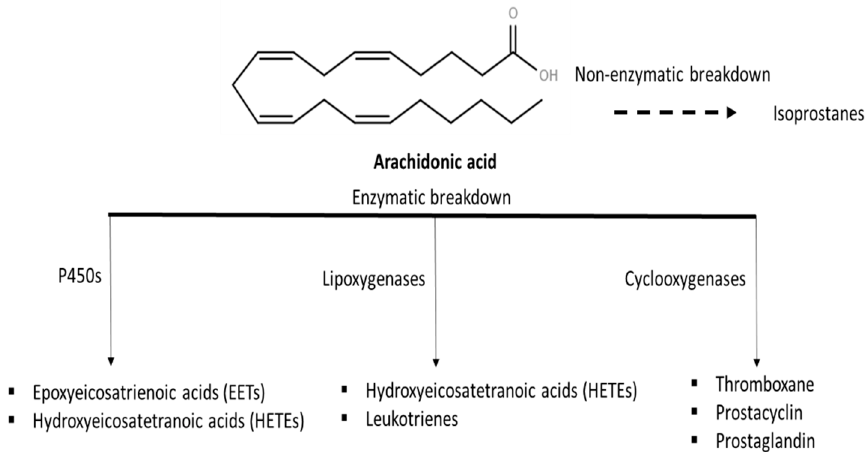
Figure 5. Schematic illustration of transformation of arachidonic acid through non-enzymatic and enzymatic pathways [105]. Structures: (The LIPID MAPS Lipidomics Gateway, 2020).